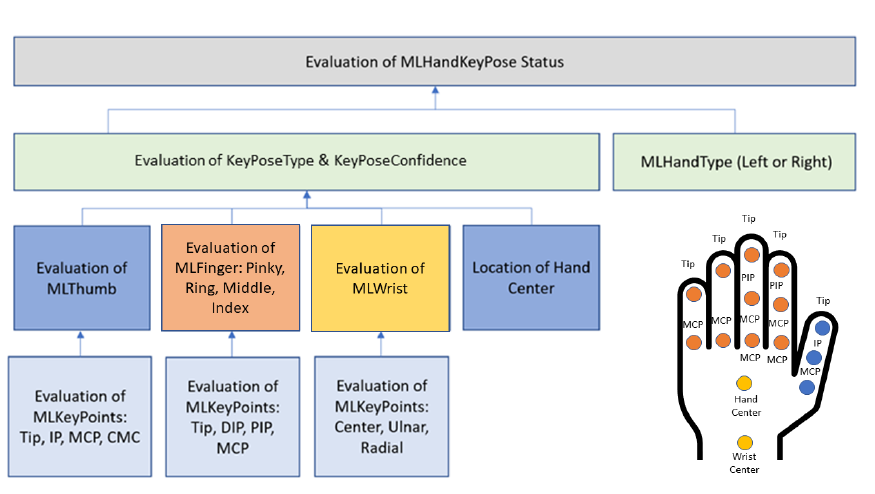
Figure 4. Magic Leap hand key points for gesture detection